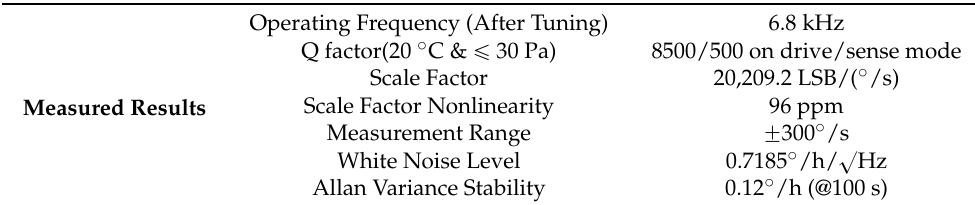
Table 5. Measured results of the